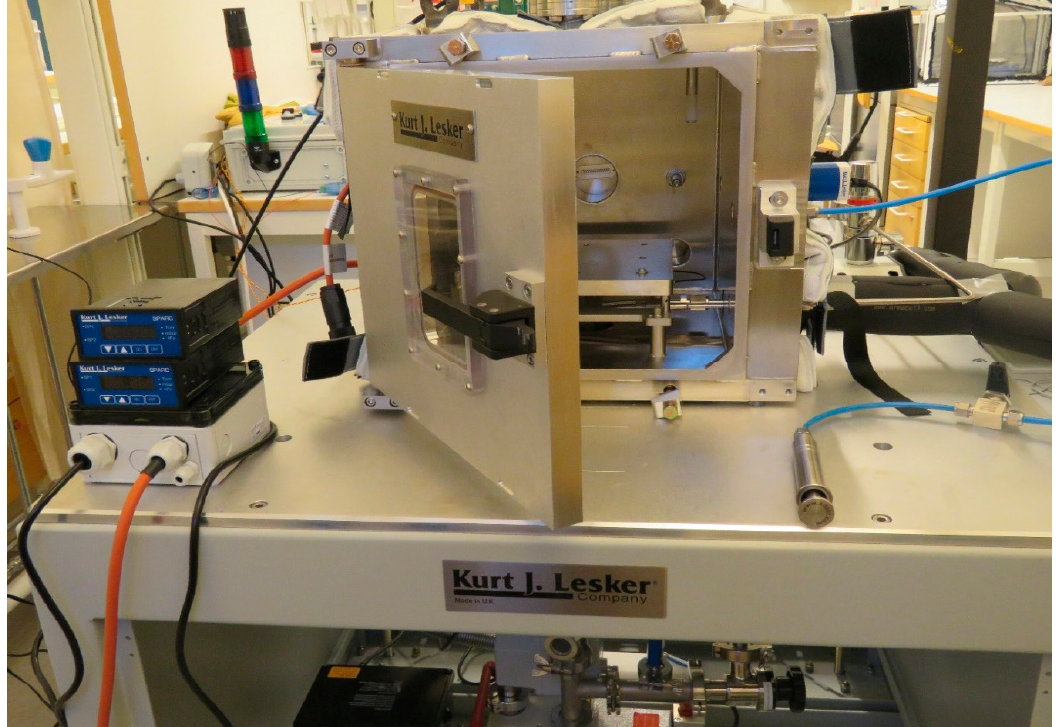
Figure 1. Overview of the SpaceQ chamber, without the heating jacket, fitted with different components.